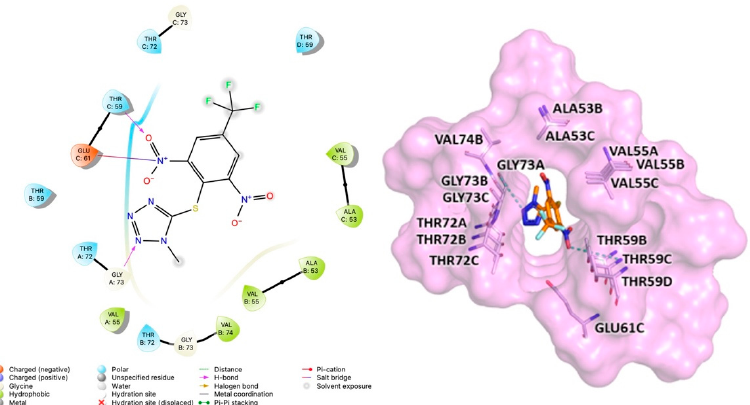
Figure 7. Binding site of α -Syn identified through docking studies for compound MeSC-04. The image was created with the PyMOL program [25] .